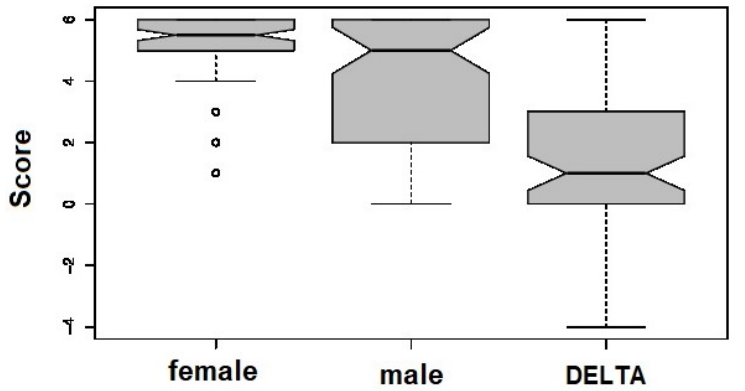
Figure 1. Box plot representation of the FSS differential response between male and female patients with ME/CFS treated with O 2 -O 3 -AHT.